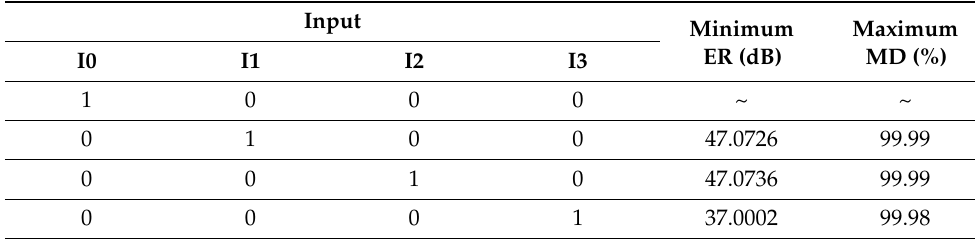
Table 4. Minimum ER of the proposed 4 × 2 encoder logic gate.